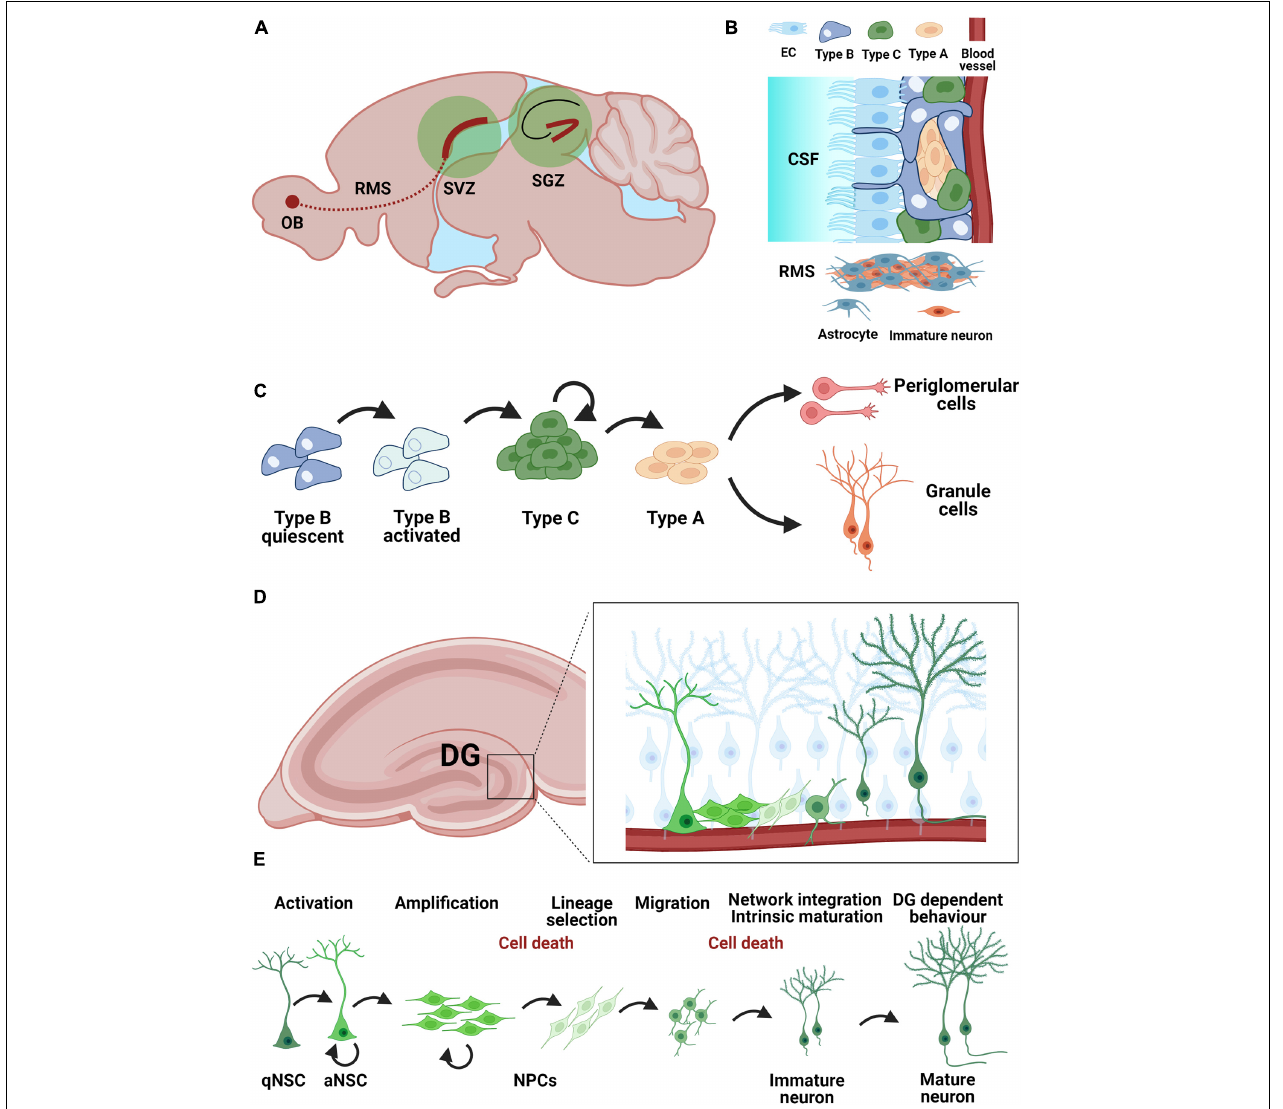
FIGURE 1 | Neurogenic niches in the adult mouse brain. (A) Neurogenic niches in the adult brain include the subventricular zone (SVZ) and the subgranular zone (SGZ) of the hippocampal dentate gyrus. Immature neurons from the SVZ migrate along the rostral migratory stream (RMS) toward the olfactory bulb (OB) (B) Organization of the SVZ neurogenic niche. Neural stem cells (Type B) contract both the cerebrospinal fluid (CSF) via ependymal cells (EC) and blood vessels as a mechanism for humoral regulation. Immature neurons migrate along the RMS using astrocytes as guides. (C) Developmental steps during neurogenesis in the SVZ: quiescent astrocytic stem cells (Type B) in the SVZ become activated and give rise to neuroblasts (Type A) via a pool of transient-amplifying cells (Type C). Neuroblasts can give rise to granule cells and periglomerular cells. (D) Adult neurogenesis in the dentate gyrus : localization of the SGZ neurogenic niche within the hippocampus. (E) Adult neurogenesis in the dentate gyrus arises from a population of quiescent neural stem cells (qNSC) with astrocytic characteristics Activated neural stem cells (aNSC) give rise to a pool of amplifying neural precursor cells (NPCs), which further undergo lineage selection, migration, morphological and functional maturation as well as network integration before becoming mature granule cells by about 8 weeks post-mitosis. The survival of adult born granule cells is regulated during an early (24–48 h post-mitosis) and a late phase (12–16 days post-mitosis) mostly through